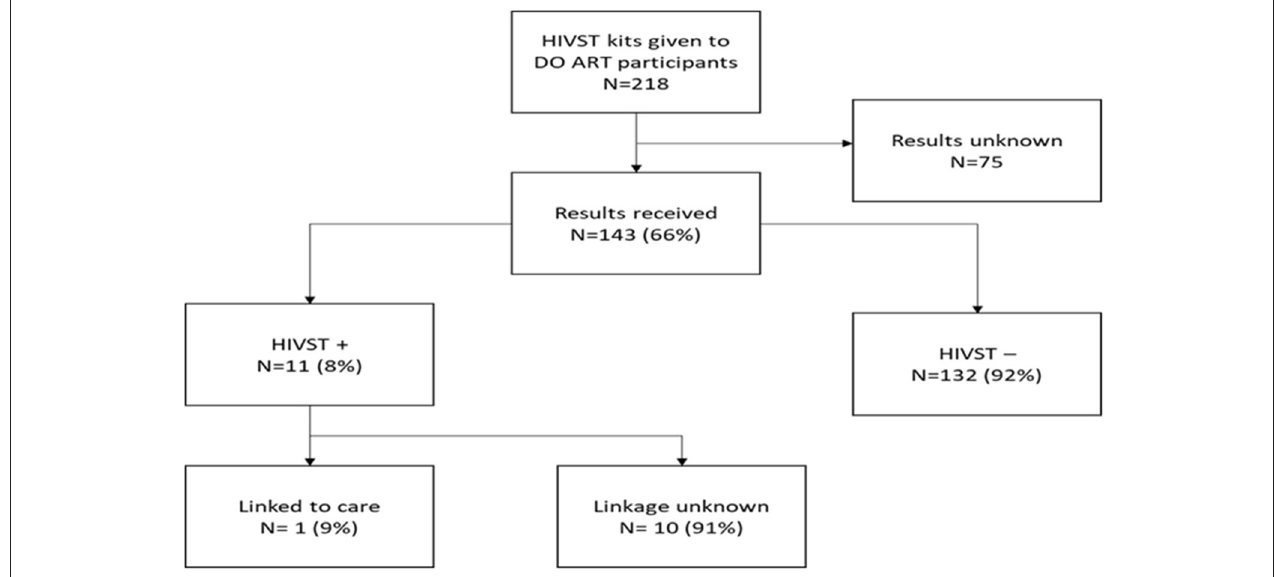
FIGURE 1 | Secondary HIVST kit distribution